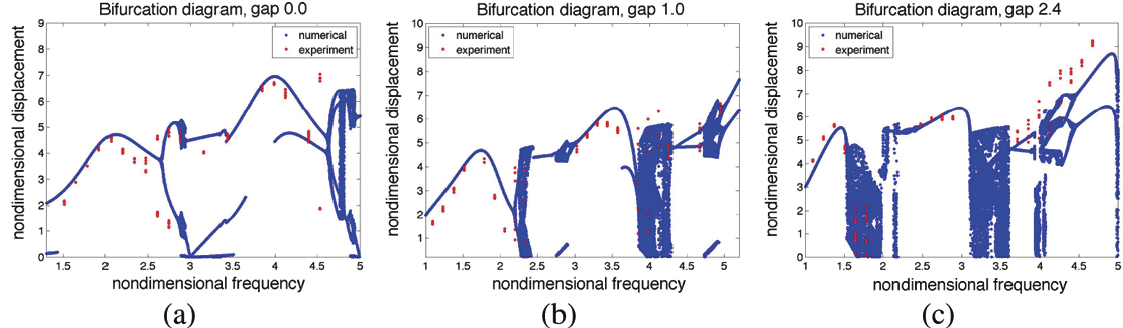
Fig. 15. Bifurcation diagram: hammer displacement, numerical simulation (blue)/ experimental data (red) comparison: a) Gap 0.0 mm; b) 1.0 mm; c) 2.4